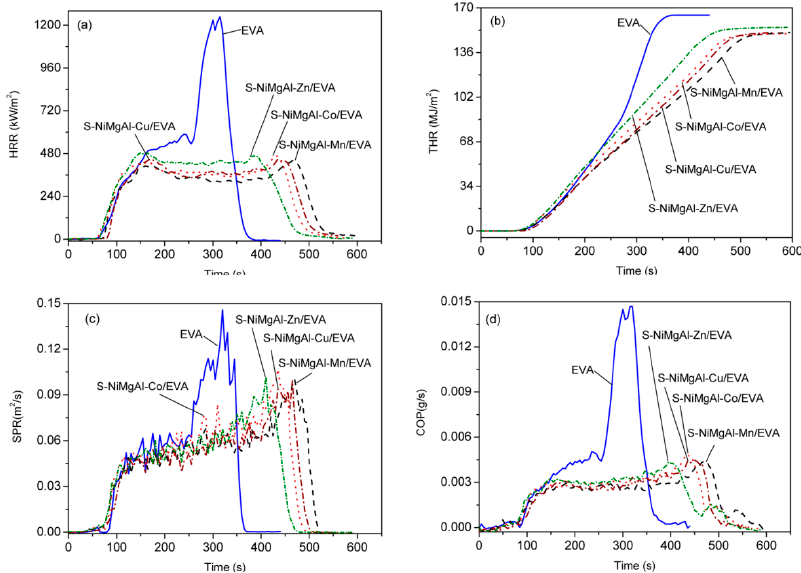
Figure 7. Cone calorimetry results of EVA and its composites with 20 wt. % LDHs. ( a ) Heat release rate (HRR) curves; ( b ) total heat release (THR) curves; ( c ) smoke production rate (SPR) curves and ( d ) production rate of CO (COP) curves. Table 1. Cone calorimetry data for composites with 20 wt. % loading of stearate surface ‐ modified LDHs containing transition metal elements (heat fl ux of 50 kW/m 2 ).